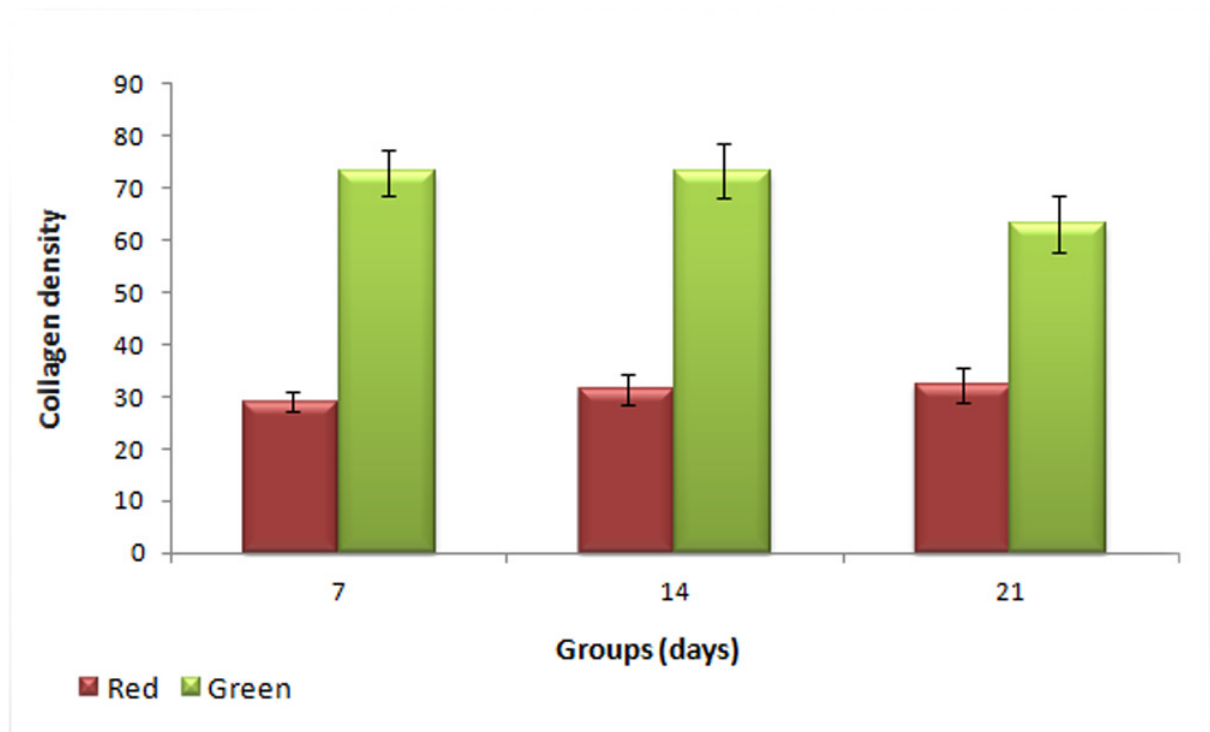
Figure 5. Qualitative evaluation of collagen deposition in the skin of mice after injection of Bothrops cotiara venom (100 µg/50 µL) or 0.9% NaCl solution. Type I (yellowish-red) and III (green) collagen on histological sections of the skin stained with picrosirius red were examined using cross-polarization optics. The quantification of the collagen fibers density per section was done on images taken at 200x magnification, according to their coloration, using the software ImagePro Plus. Three random fields in four different areas of the skin were analyzed, totaling 12 fields per animal. Results are represented as mean ± SEM. *Statistical significance when compared with control group for p <